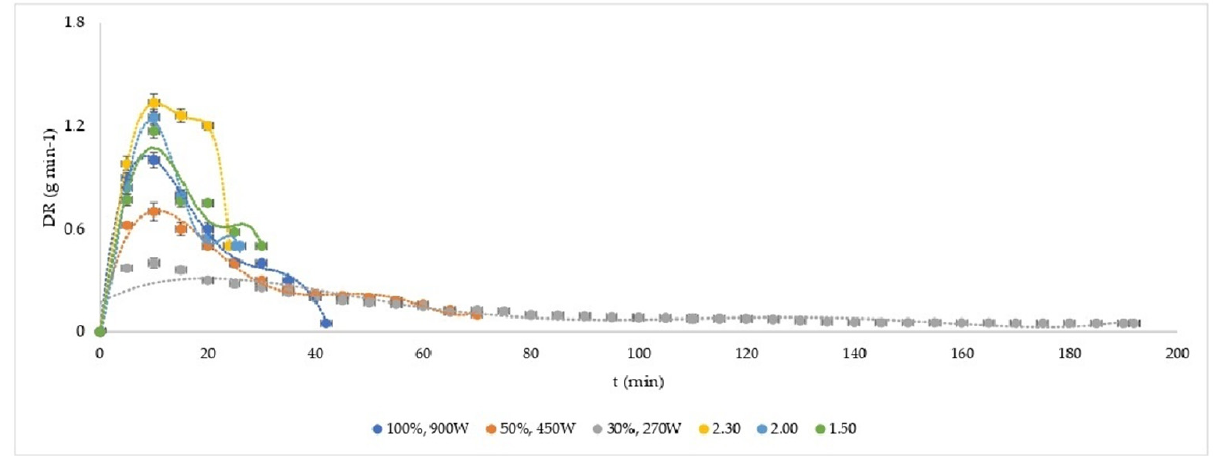
Figure 2. Effects of dehydration method (MD, MCD) on DR. Figure 2. E ff ects of dehydration method (MD, MCD) on DR. Table 1. Average values and standard deviations of t, D eff , E, CO 2 , and experimental models for MR All curves for drying kinetics had the same shape, with di ff erent drying times to a and DR of MD and MCD of constant mass. Drying time t (Table 1) statistically signi fi cantly depended directly on the chosen dehydration method. Table 1. Average values and standard deviations of t, D e ff , E, CO 2 , and experimental models for MR and DR of MD and MCD of chokeberry.